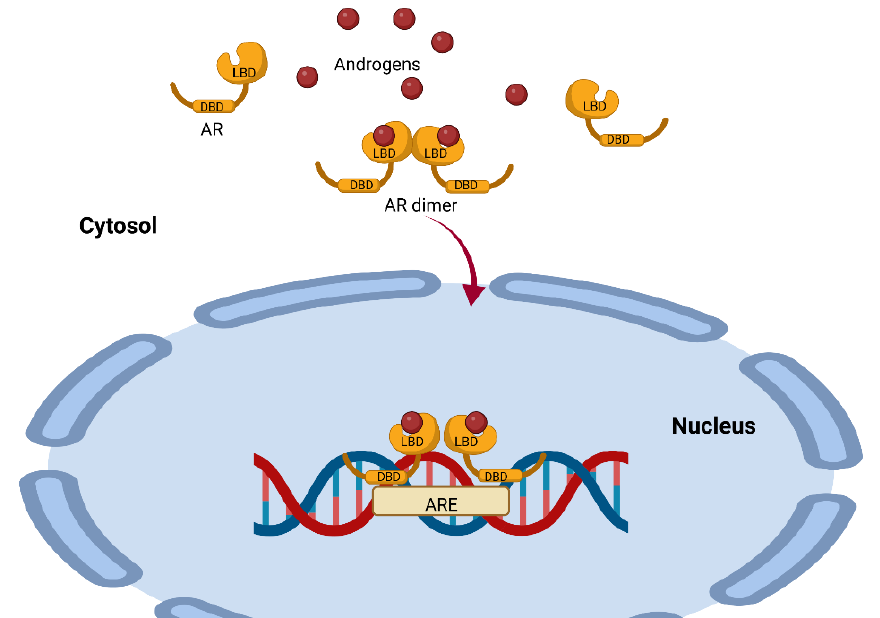
Figure 2. Representation of the mechanism of androgen action mediated by the androgen receptor. The AR has a highly conserved ligand-binding region (LBD) and a highly conserved DNA-binding region (DBD). Once the ligand binds to the AR, it dimerizes with another AR–ligand complex and translocates to the nucleus, where it binds to androgen response elements (AREs), modulating the expression of several genes. This image was based on the text of [28] and created using the BioRender.com software.